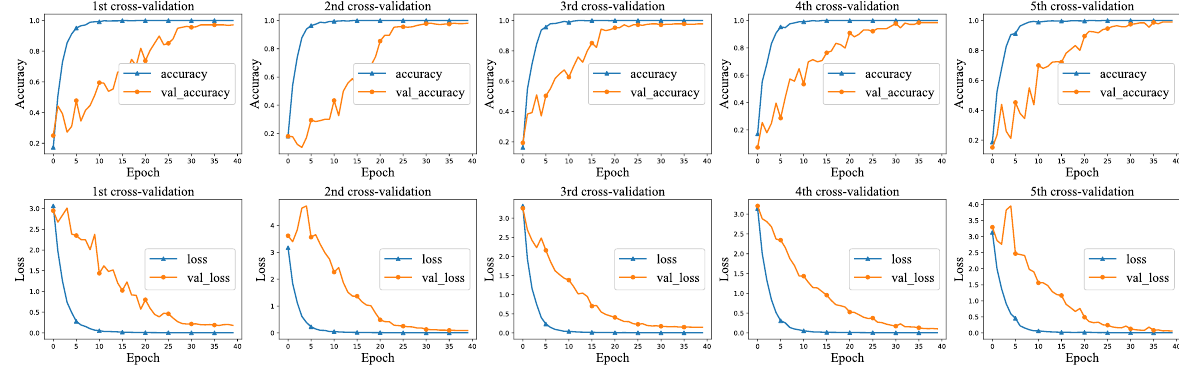
Figure 5. Multi-classifier training and validation visualization.